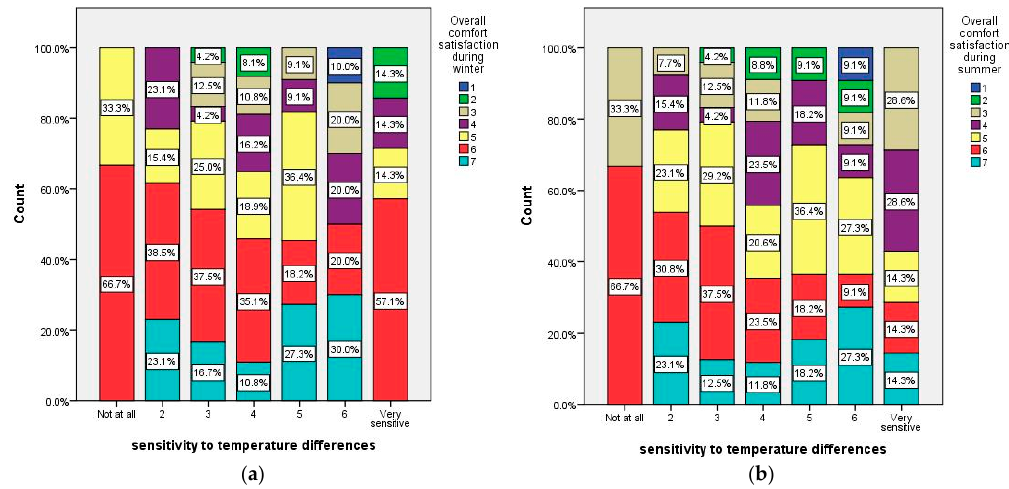
Figure 17. Relation between sensitivity in temperature differentiations and the overall comfort satisfaction during ( a ) winter and ( b ) summer.